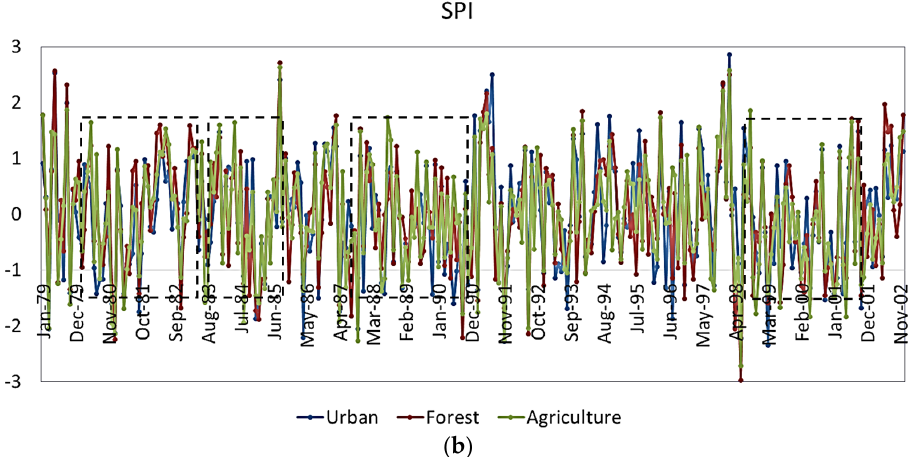
Figure 4. ( a ) Time series for monthly rainfall patterns for Northeast Florida; dash box areas represent drier periods; ( b ) Time series of Standardized Precipitation Index (SPI) for Northeast Florida; dash box areas represent drier periods.